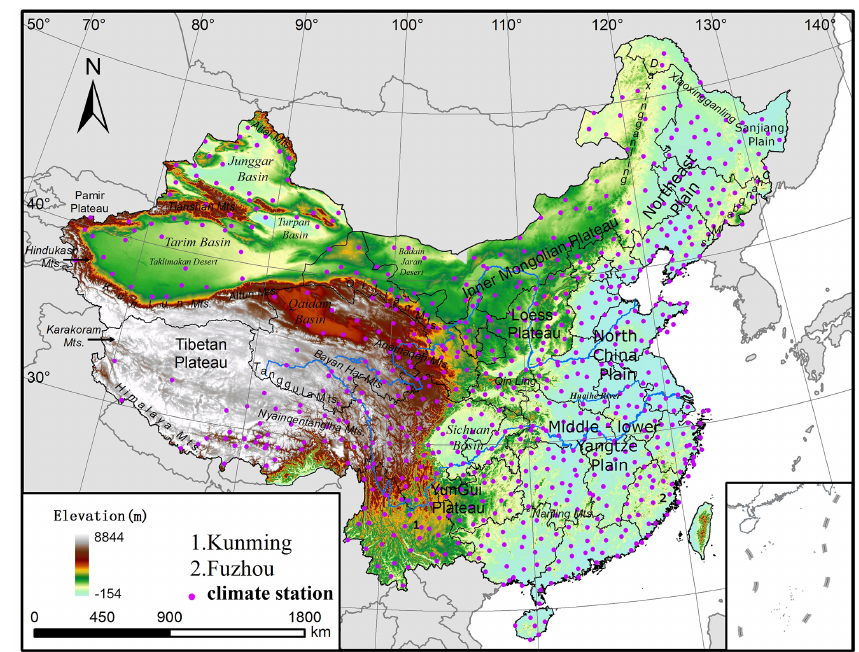
Figure 1. Locations of weather stations and major basins, mountains, and plains mentioned in the paper, overlying the digital elevation model for